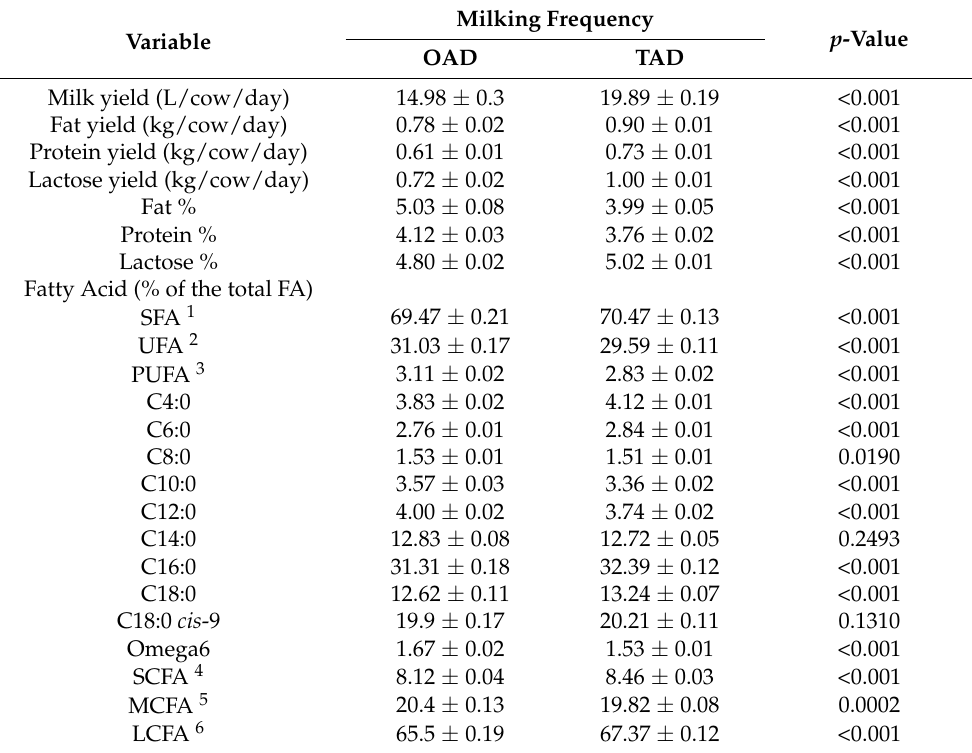
Table 3. Least-squares means and standard errors of daily yields of milk, fat, protein and lactose, gross milk composition and fatty acid composition of cows milked once a day (OAD) and twice a day (TAD) during the 2020–2021 production season. Milking Frequency p -Value Variable